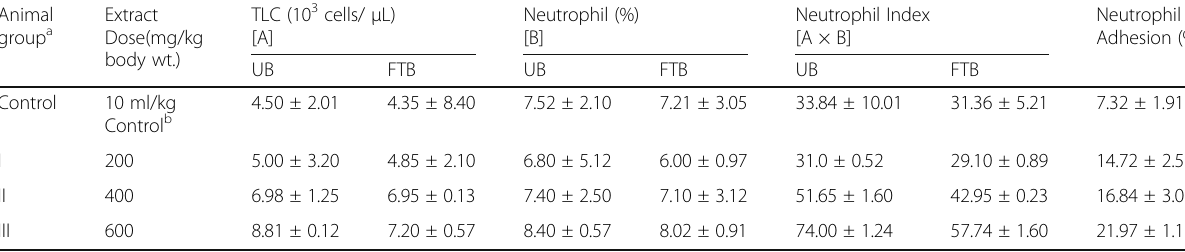
Table 8 Effect of methanolic leaf extract of B. lupulina on neutrophil adhesion Animal Extract group a Dose(mg/kg body wt.)